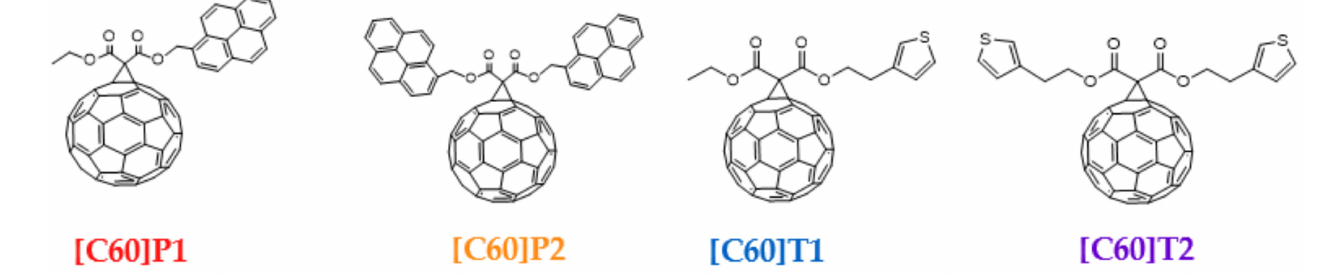
Figure 2. Chemical structure of the studied fullerene